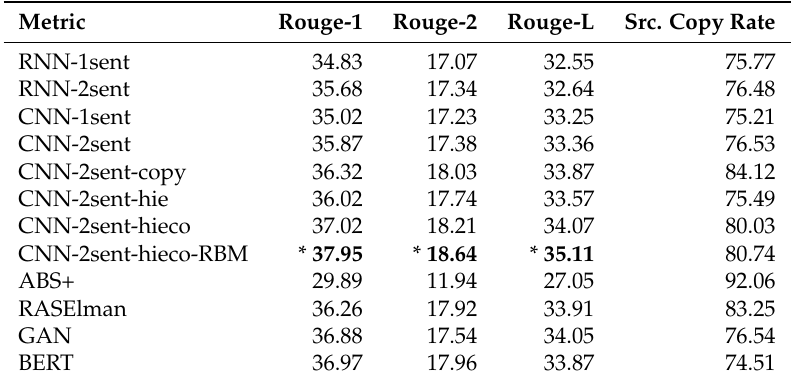
Table 1. The experimental results on Gigaword Corpus. * indicates the statistical significant improvement.